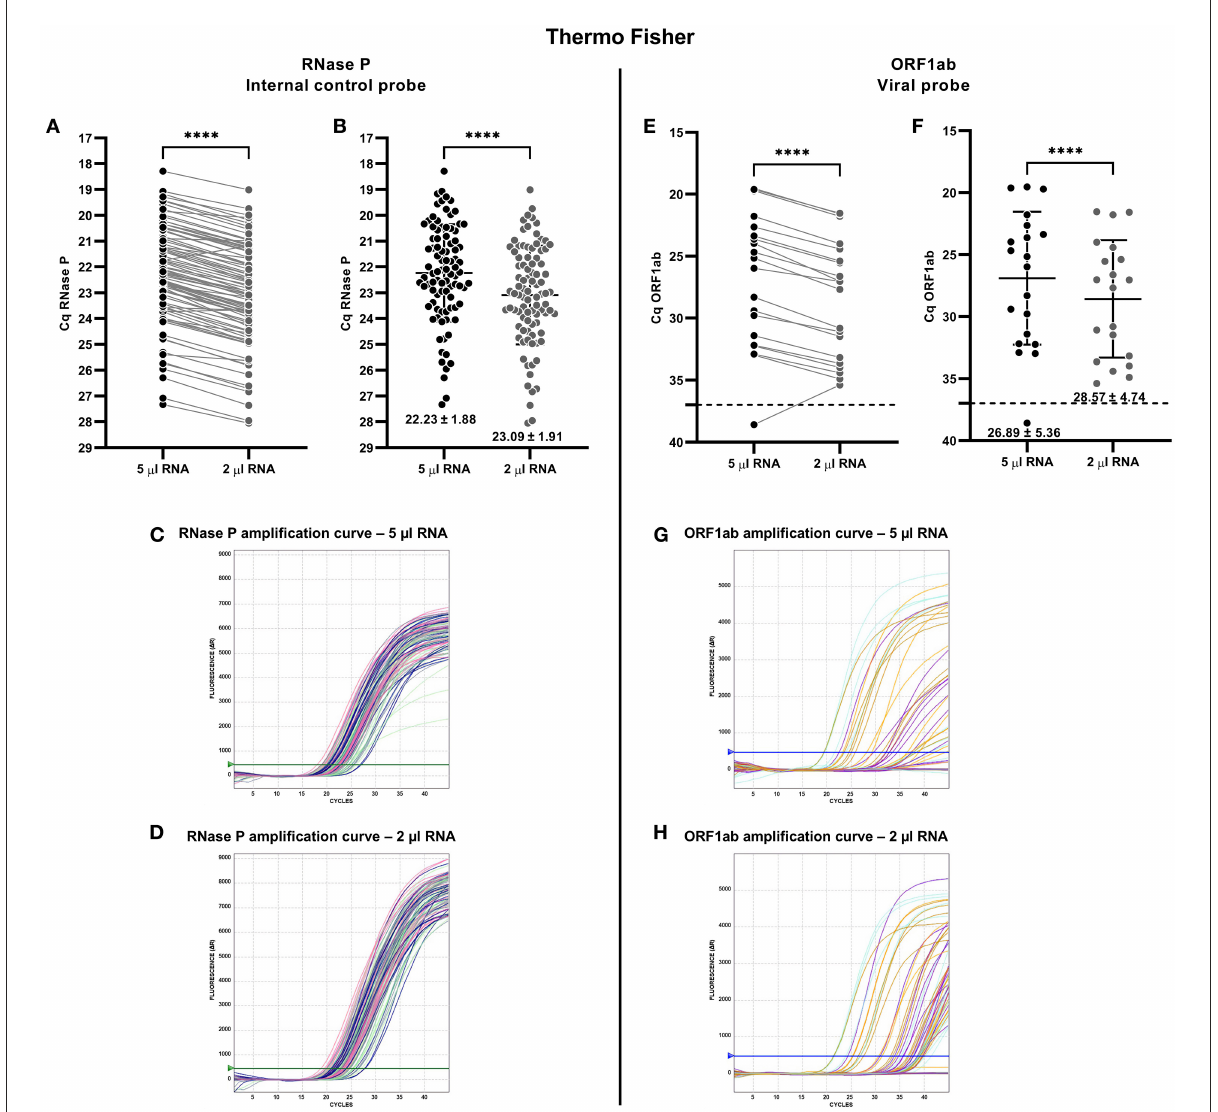
FIGURE1 Comparative analysis for detecting SARS-CoV-2 from nasopharyngeal swab (NPS) samples using RNase P and ORF1ab gene probes from Thermo Fisher RT-qPCR kit. The comparison was made from the same NPS sample loading the recommended volume of extracted RNA (5 µ l of total RNA, recommended by the manufacturer; black spots) and 2 µ l of total RNA (gray spots). Each spot is an analyzed sample for each volume condition (5 µ l; 2 µ l). For graphs (A,E) , the line connecting the points shows the paired results obtained from the same sample analyzed by loading the two different volumes. Cq = 46 denotes no amplification (No Cq). (A) Paired quantification cycle (Cq) analysis for RNase P probe of each sample assessed. (B) Cq means value (mean ± SD) for the RNase P probe amplification. RNase P probe amplification curves loading (C) 5 µ l and (D) 2 µ l of total RNA. (E) Paired Cq analysis for ORF1ab probe of each sample assessed. (F) Cq means value (mean ± SD) for the ORF1ab probe amplification. The broken line indicates the Cq cut-off value (Cq ≤ 37) recommended by the manufacturer. ORF1ab probe amplification curves loading (G) 5 µ l and (H) 2 µ l of total RNA. For statistical analysis, paired two-sided Student T -test was applied ( n = 91 NPS blind selected samples, 20 positives for SARS-CoV-2). **** p < 0.0001.